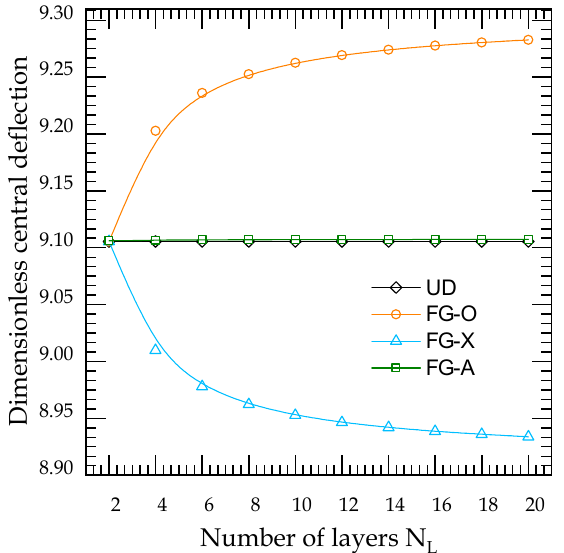
Figure 9. Dimensionless central deflection of simply supported GRNC plate in terms of number of layers for various GPLs reinforcement patterns (g (cid:2891)(cid:2900)(cid:2896)∗ = 1%) . In Figure 10, the impact of nonlocal and small-scale parameters on the central deflection of simply supported GRNC plates for various GPLs reinforcement patterns is investigated. As we demonstrated in the buckling analysis, the inclusion of nonlocal parameter µ reduces the plate stiffness, so, transverse displacement increases. In addition, the increase in small-scale parameter λ leads to a decrement in transverse displacement.